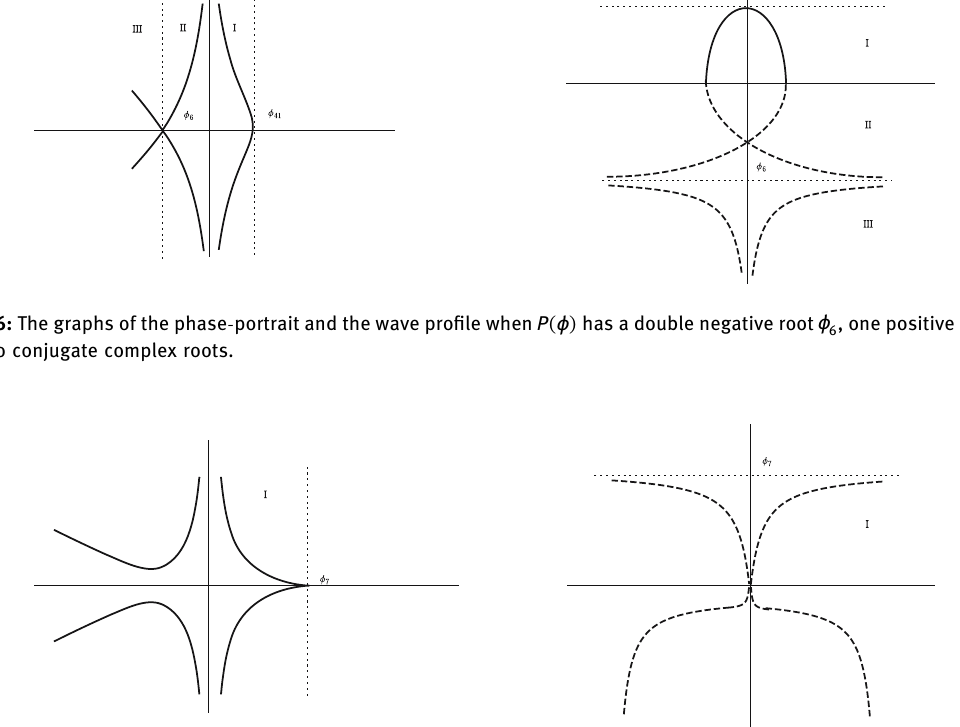
, ϕ and one single root ϕ 4 5